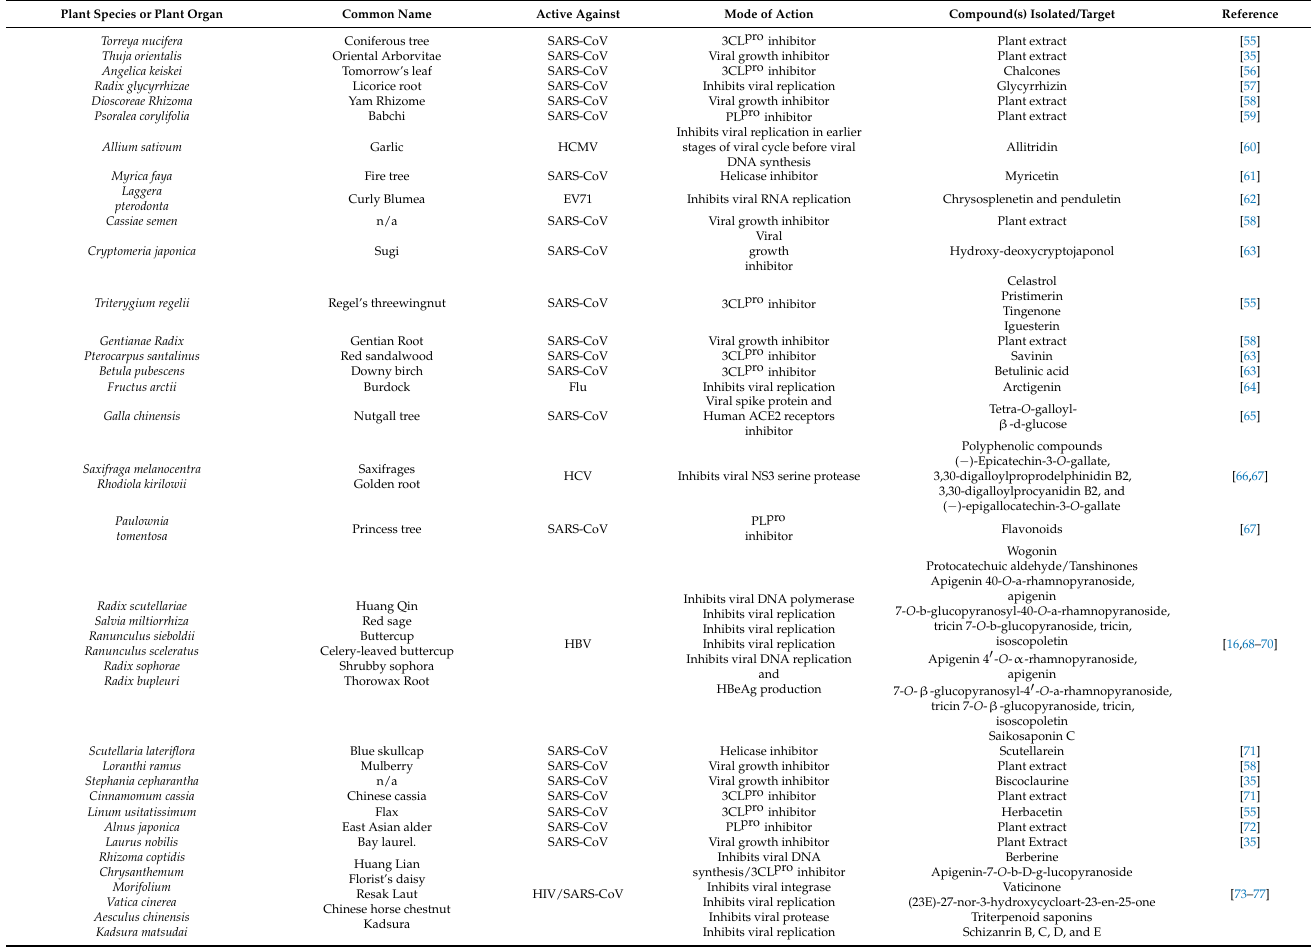
Table 1. Example of biological active agents extracted from medicinal plants against SARS-CoV and other virus